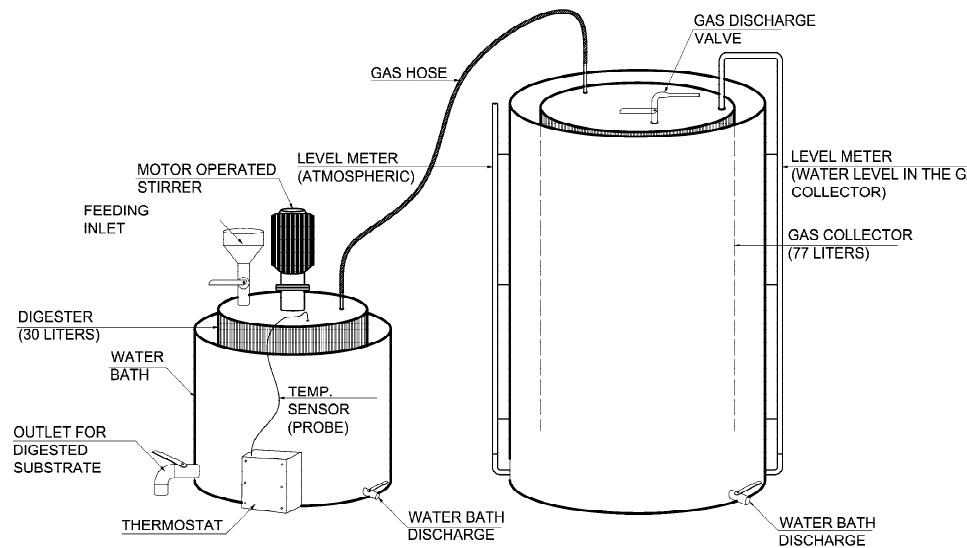
Figure 1. The schematic view of the pilot-scale equipment from [32]. Three identical reactors were used for the experiment.